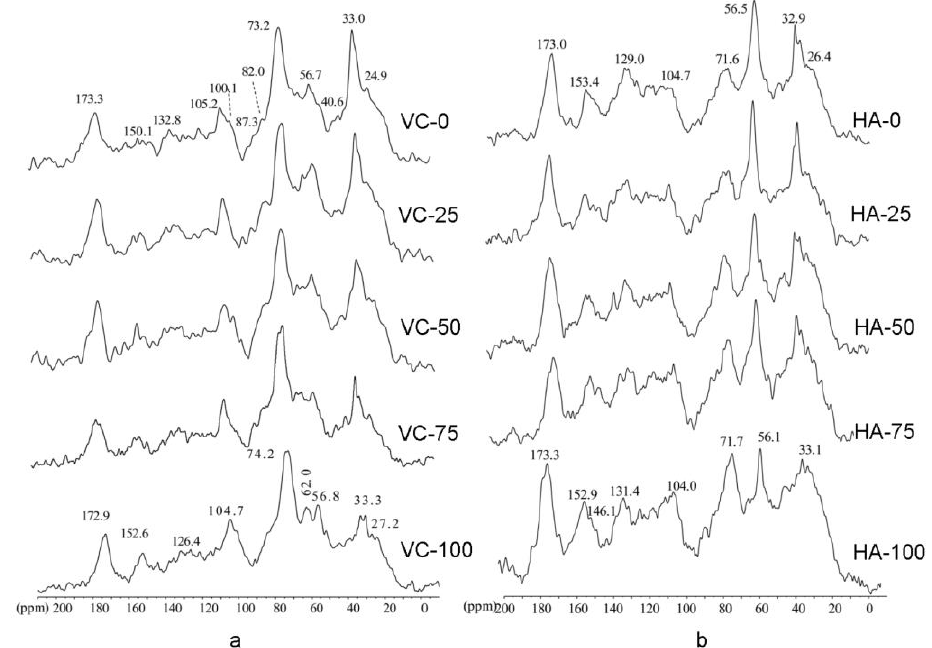
Figure 5. 13 C CP-MAS NMR spectra of ( a ) vermicomposts (VC) and ( b ) HAs extracted from vermicomposts at increasing rate of CM replacement (0, 25, 50, 75 and 100 are the percentages of cotton residues). Adapted from Ref. [108].